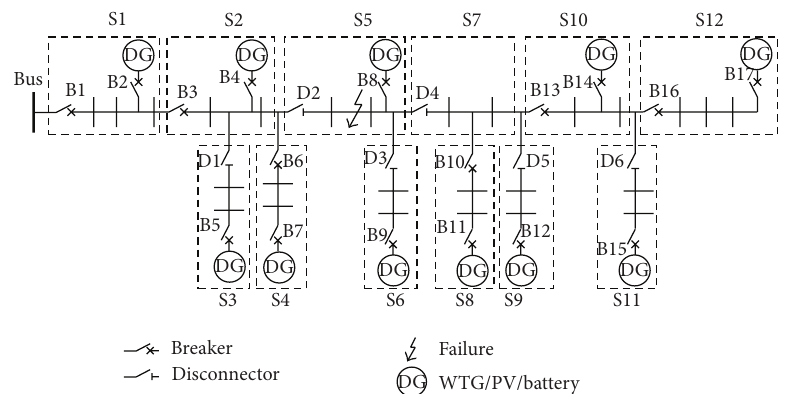
Figure 3: A distribution system with WTG, PV, and